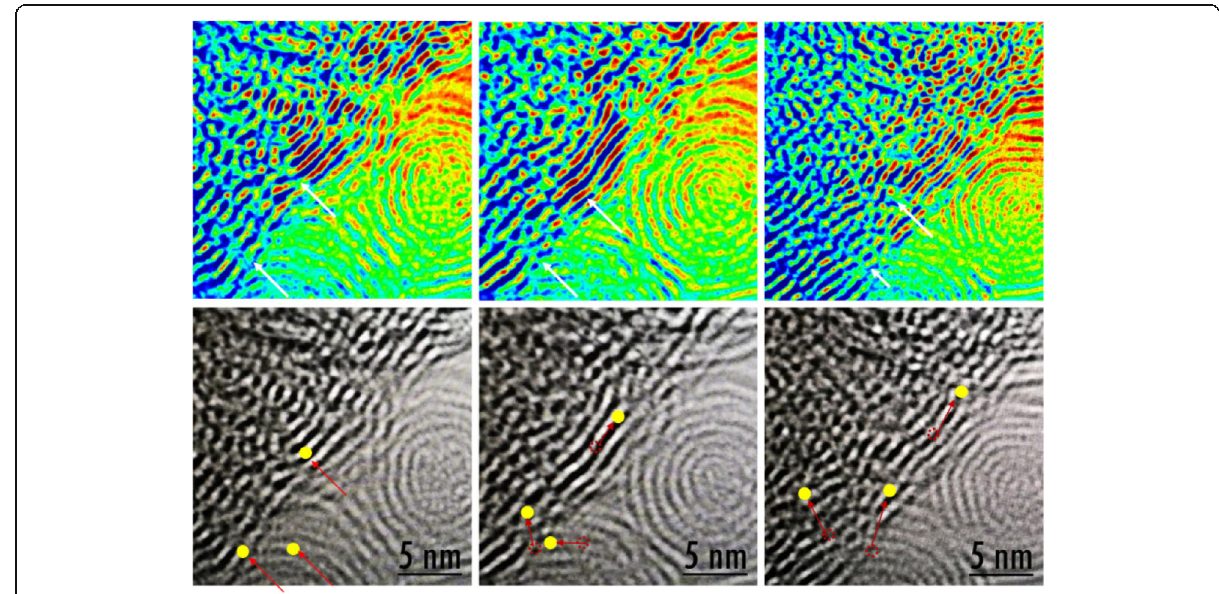
Fig. 7 TEM image of nano-graphene multi-stage self-assembly